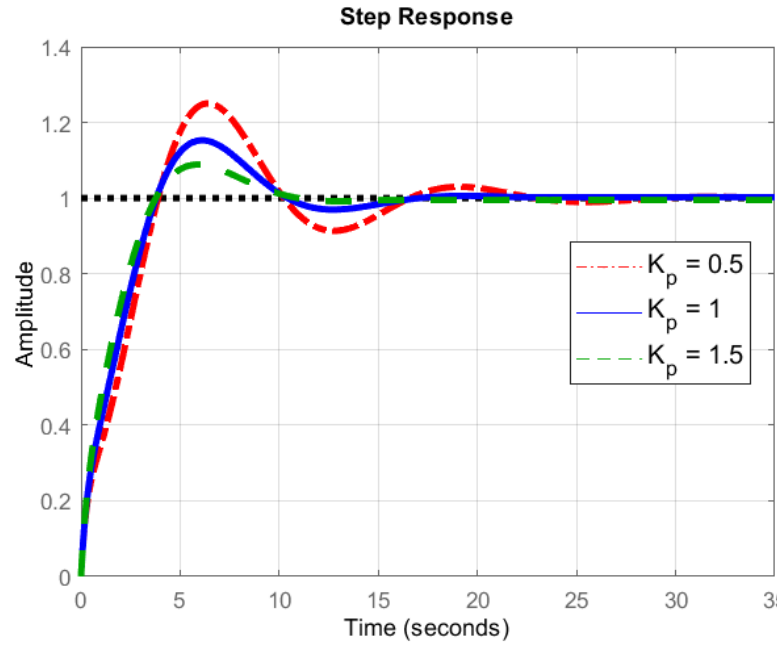
Figure 8. Principle of proportional